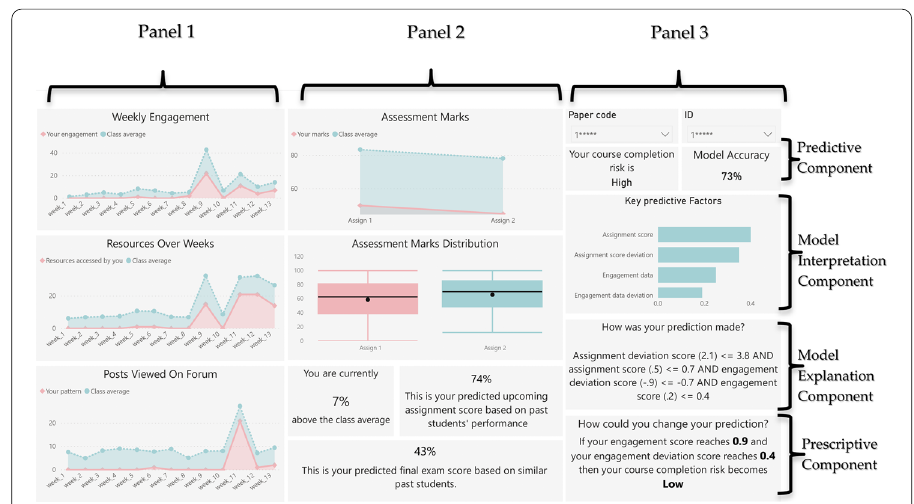
Fig. 3 Learning analytics dashboard designed for